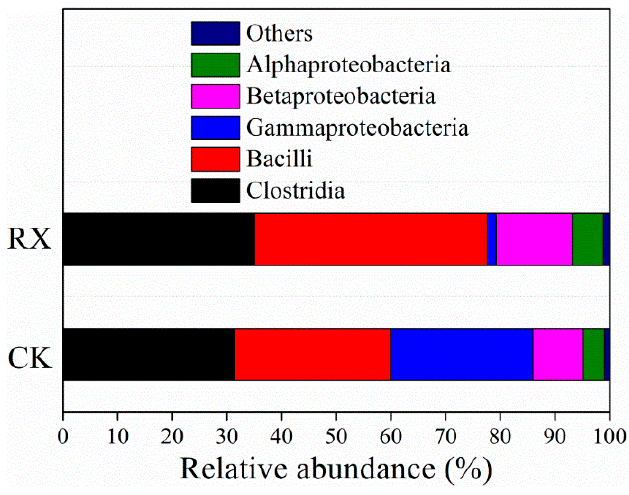
Figure 8. Bacterial community in neutralized BR by ZH-1 at class level. Table 1. Summary of Illumina Miseq high-throughput sequencing of 16S rRNA gene. Sample